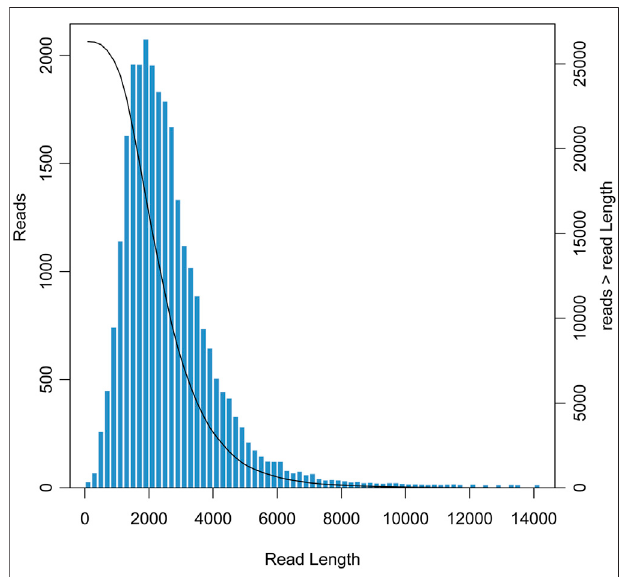
FIGURE 1 | Length distribution of unigenes obtained from the Cipangopaludina chinensis library.